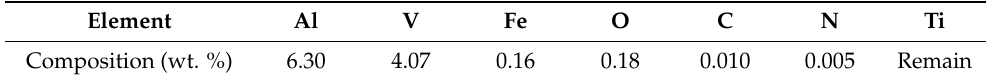
Table 1. Chemical composition of Ti-6Al-4V. Element Al V Fe O C N Ti Composition (wt.